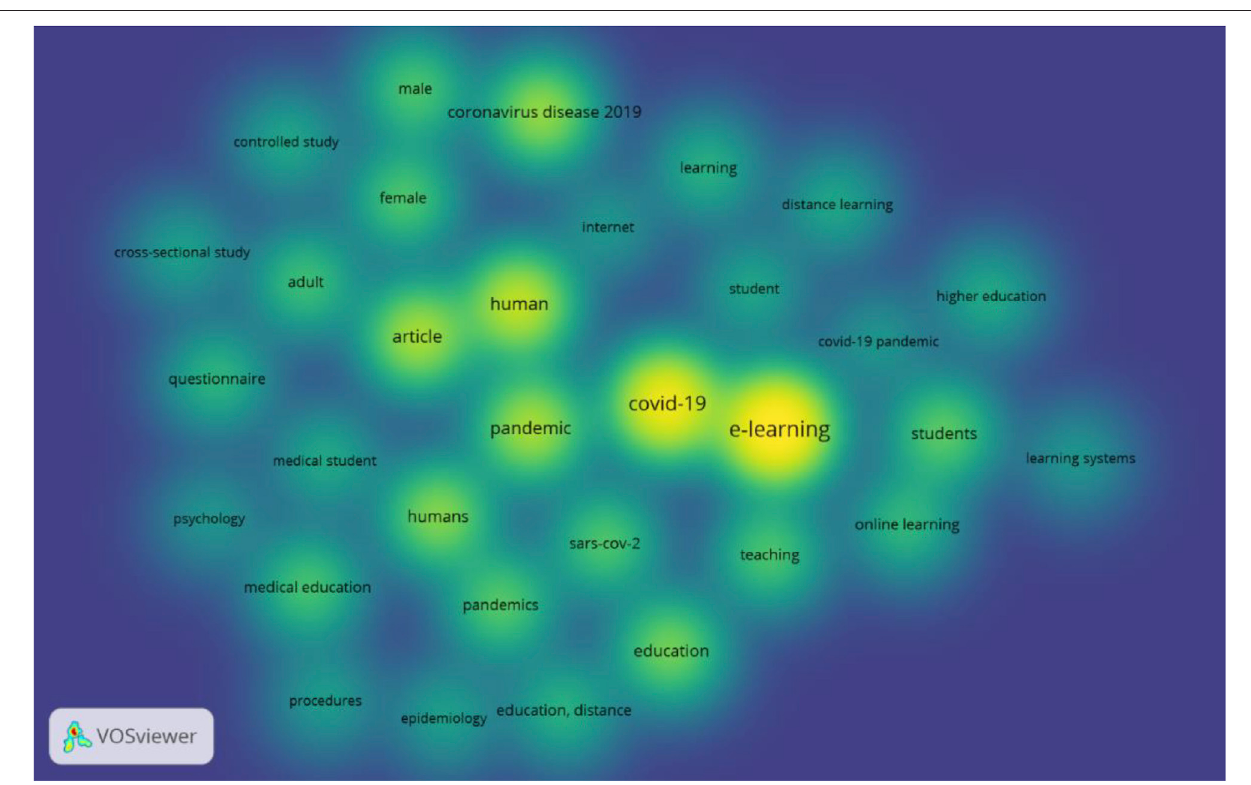
FIGURE 5 | Visualization map of keywords co-occurrence in the fi eld of e-learning and COVID-19.